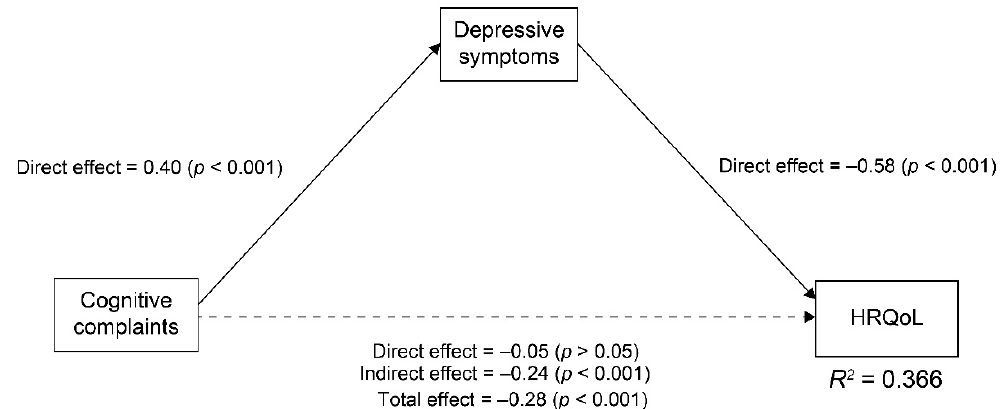
Figure 1. Path analysis of cognitive complaints, depressive symptoms, and HRQoL using COBRA, PHQ-9, and EQ-5D-5L Scores, respectively ( n = 525). The numbers next to the arrows demonstrate the standardized path coefficients. The solid arrows represent the statistically significant paths and the dashed arrow shows the non-significant path. We did not use the goodness-of-fit index because of the saturation model. R 2 indicates coefficients of determination.